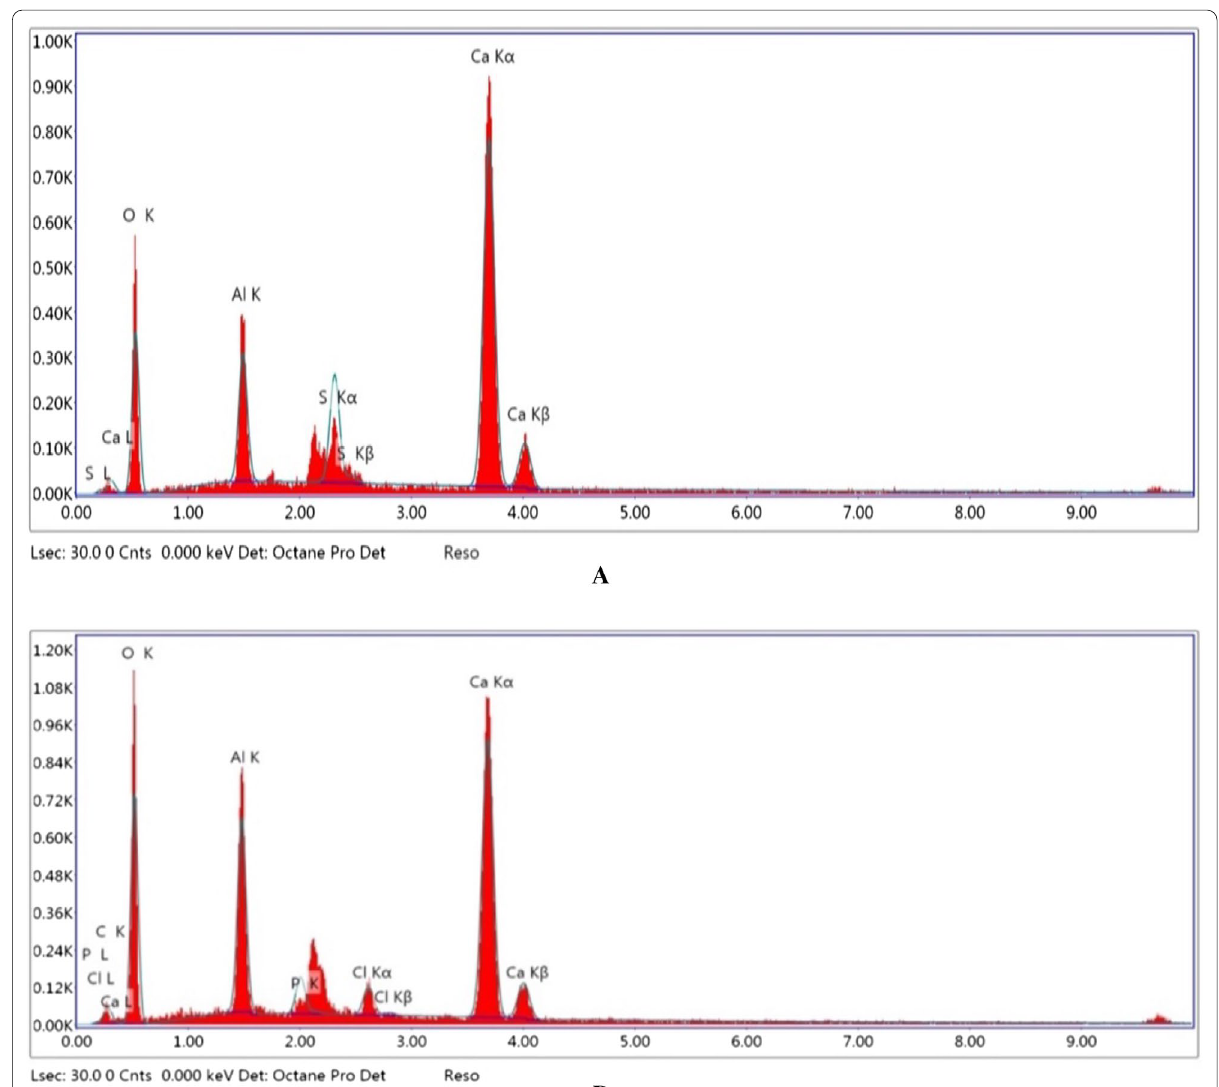
Fig. 7 EDS graphs of samples: A‑ samples cured under distilled water, B‑ samples cured under artificial saliva solution